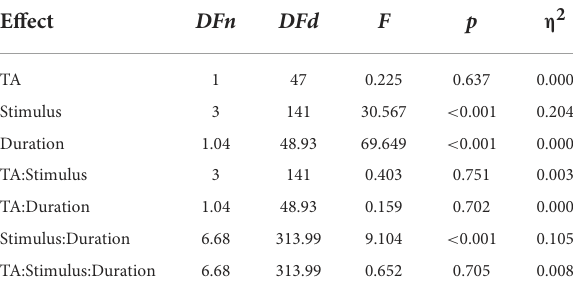
TABLE 1 Mixed analysis of variance results for trait anxiety (TA), stimulus, and